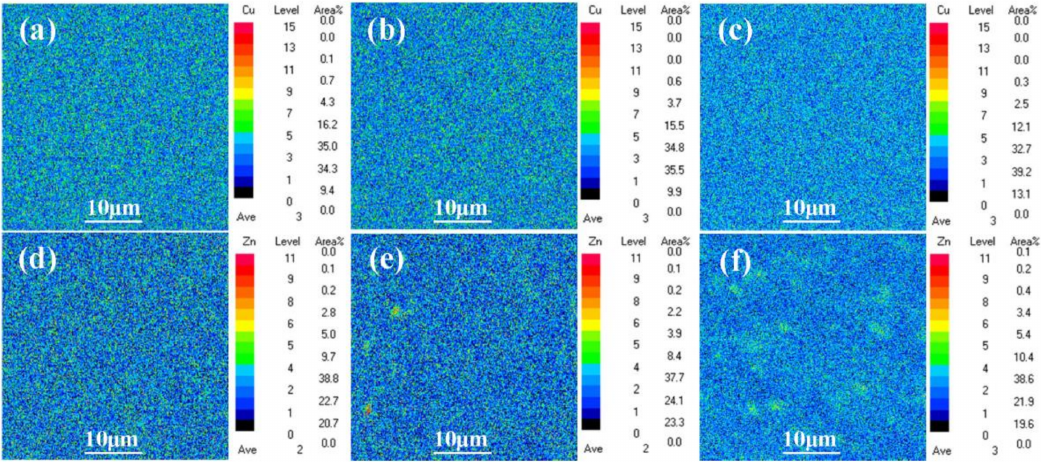
Figure 5. Elemental mapping of ( a – c ) Cu on Cu x Bi 2 TeI and ( d – f ) Zn on Zn y Bi 2 TeI samples. ( a ) x = 1%, ( b ) x = 1.5%, ( c ) x = 2%, ( d ) y = 1%, ( e ) y = 1.5%, ( f ) y =